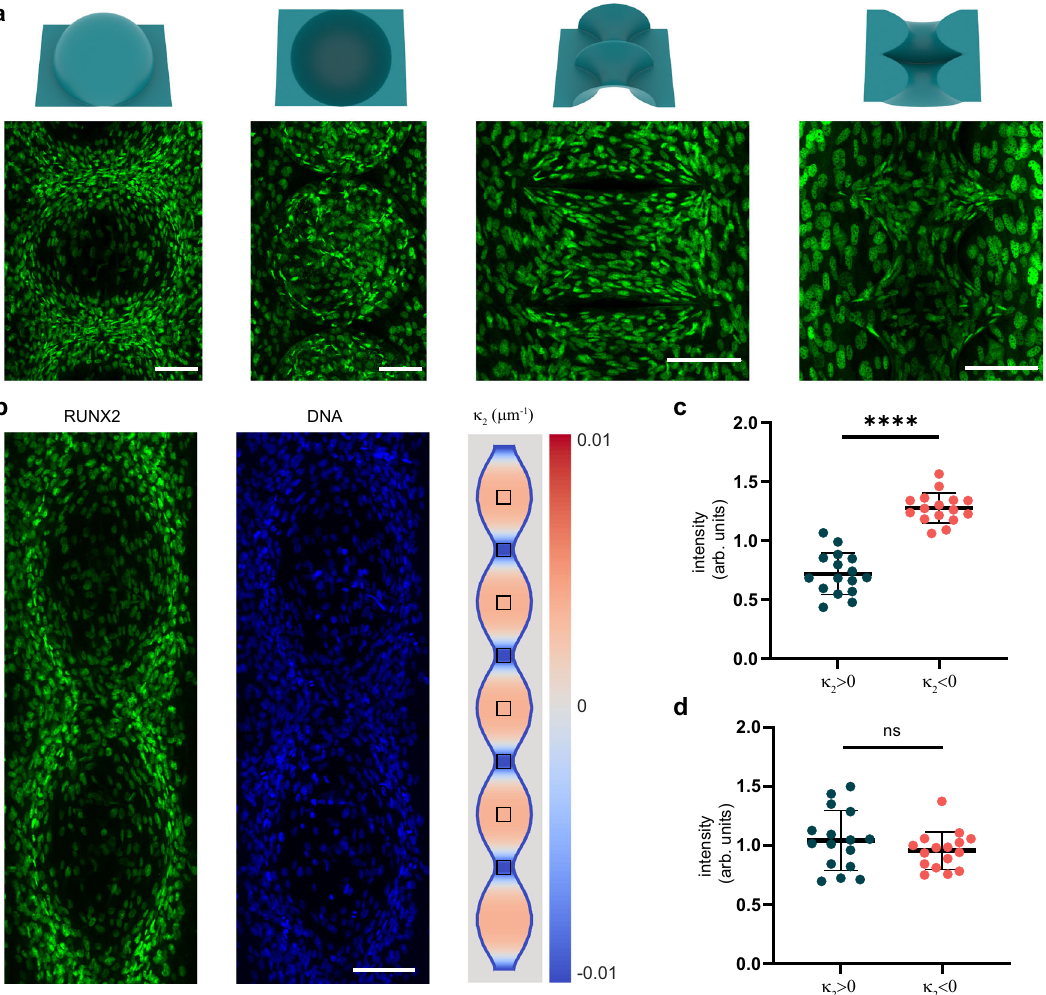
Fig. 6 | RUNX2 expression on curved substrates. a Representative maximum intensity projections of RUNX2 expressionatday8 on the convex sphere, concave sphere, convex catenoid, and concave catenoid substrates. b Maximum intensity projection of RUNX2 and DNA (DAPI) expression on a convex unduloid substrate. On the right side of the panel, a curvature map of κ 2 of the convex unduloid is shown. The squares (110×110 pixels) indicate the regions of interest (ROI) used in thesubsequentanalysis. c , d RUNX2( c )andDAPI( d )meanROIintensityversusthe